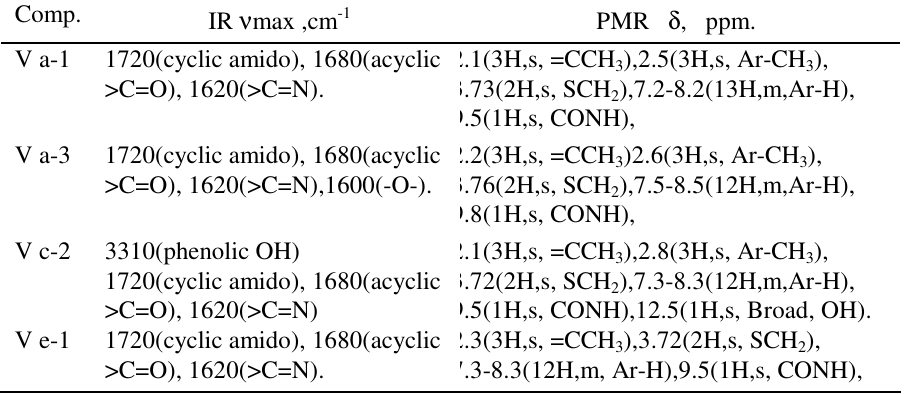
Table 10. Spectral Characteristics